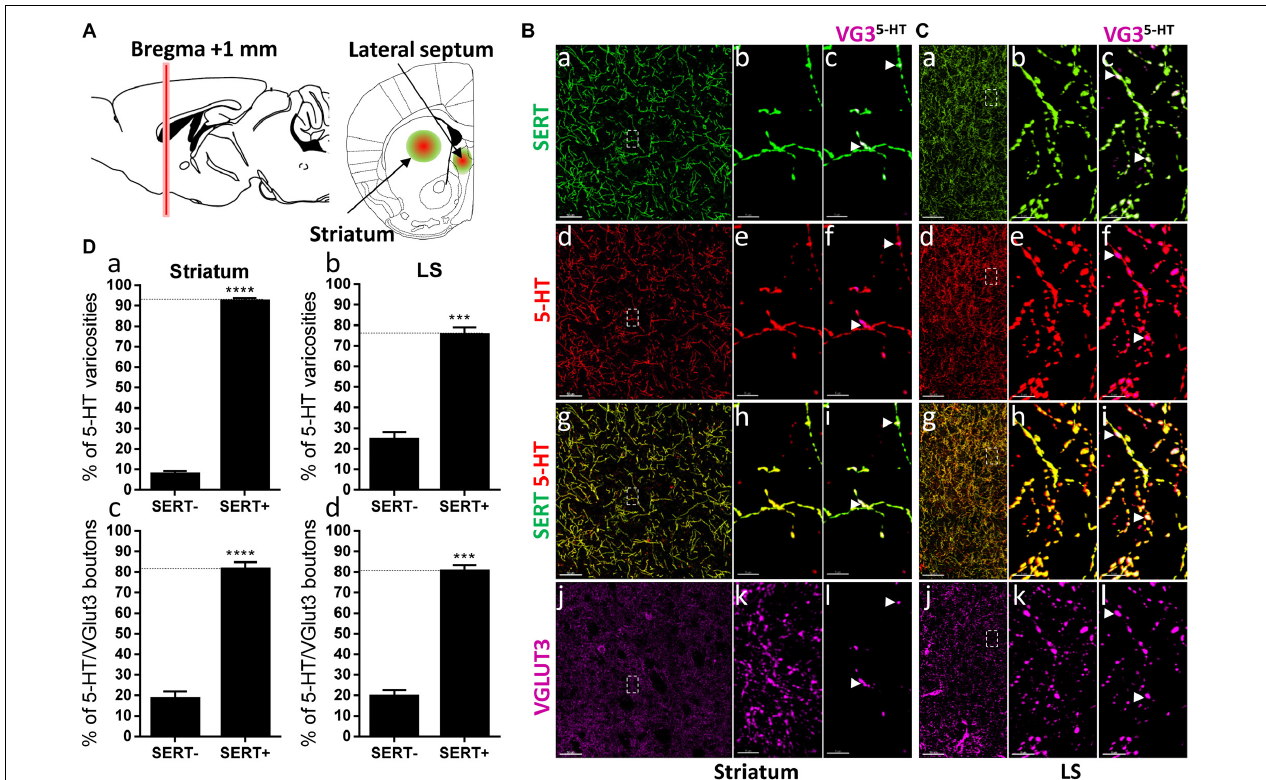
FIGURE 4 | Distribution of VGLUT3 + boutons within 5-HT + and SERT + axons in the striatum and lateral septum. (A) Schematic drawing showing the location of the acquired micrographs. Mediolateral dorsal striatum and lateral septum (LS) mosaic images were acquired at bregma + 1 ± 0.2 mm (red vertical line) (green/red circles). (B) Micrograph showing the distribution of the SERT (green, a–c ), 5-HT (red, d–f ), SERT (green) + 5-HT (red) (g–i) , and VGLUT3 (magenta, j–l ) in the striatum. Left panel shows lower magnification. Scale bar: 50 µ m. Middle (b,e,h,k) and right (c,f,i,l) panels show higher magnification of the white dashed box in the left panel (a,d,g,j) . Scale bar: 2 µ m. The right panel shows the VGLUT3 boutons co-labeled with SERT (c) , 5-HT (f) and SERT + 5-HT (i) . VGLUT3 puncta located within 5-HT varicosities were isolated using Imaris (l) . Arrowheads show 5-HT varicosities collocated with SERT and VGLUT3 (c,f,i,l) . (C) Micrograph showing the distribution of the SERT (green, a–c ), 5-HT (red, d–f ), SERT (green) + 5-HT (red) (g–i) , and VGLUT3 (magenta, j–l ) in the LS. Left panel shows lower magnification. Scale bar: 50 µ m. Middle (b,e,h,k) and right (c,f,i,l) panels show higher magnification of the white dashed box in the left panel (a,d,g,j) . Scale bar: 2 µ m. The right panel (c,f,i,l) shows the VGLUT3 boutons co-labeled with SERT (c) , 5-HT (f) and SERT + 5-HT (i) . VGLUT3 puncta located within 5-HT varicosities (l) . Arrowheads show 5-HT varicosities collocated with SERT and VGLUT3 (c,f,i,l) . (D: a,b) Quantification of the proportion of 5-HT varicosities not co-labeled (SERT - ) and co-labeled (SERT + ) with SERT in the striatum (a) and LS (b) , showing a great majority of 5-HT varicosities co-labeled with SERT. (c,d) Quantification of the proportion of 5-HT + /VGLUT3 + not co-labeled (SERT - ) and co-labeled (SERT + ) with SERT in the striatum (c) and LS (d) , showing a great majority of 5-HT + /VGLUT3 + varicosities co-labeled with SERT ( t -test, ∗∗∗∗ p < 0.0001; ∗∗∗ p < 0.001).